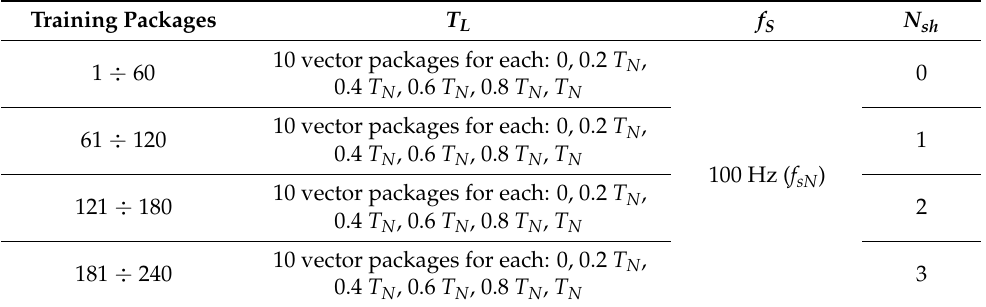
Table 1. Training data